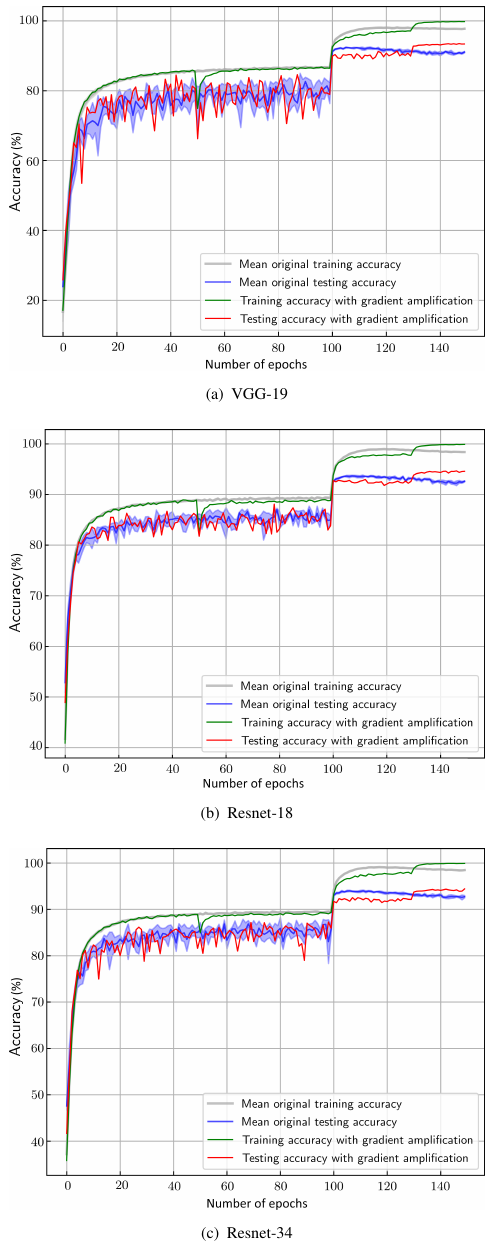
Fig. 7 Performance of the best models with gradient amplification over 150 epochs compared to original model with no gradient amplification. Original training (gray) and testing (blue) accuracies including their mean accuracies are plotted along with amplified training (green) and testing (red) accuracies. These plots demonstrate that the models do not overfit while training with